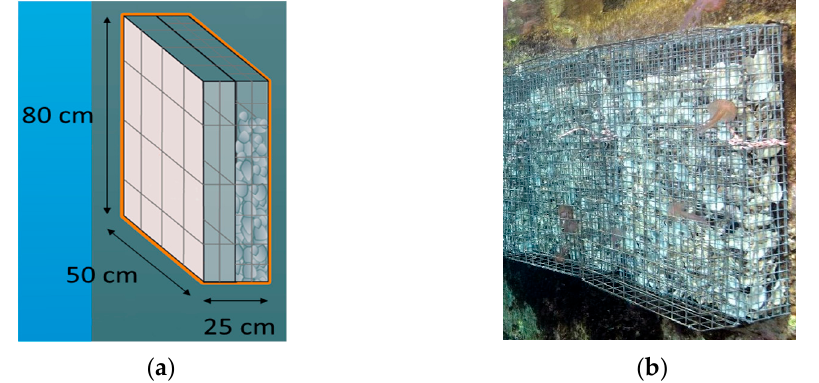
Figure 1. Dimensions ( a ) and image ( b ) of Dock Biohut structures, composed of two carbon-steel alloy cages: inner-cage filled with oyster shells (2.5 cm mesh) and empty outer-cage (5 cm